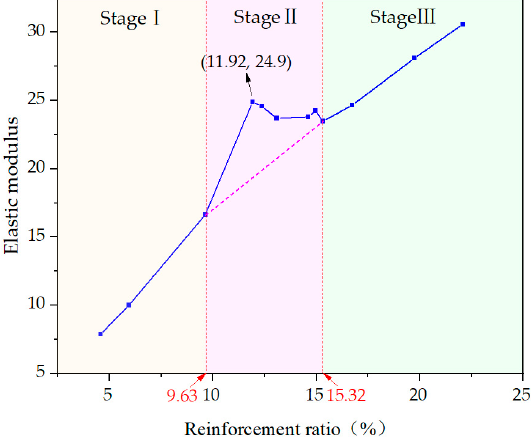
Figure 11. Elastic modulus and reinforcement ratio